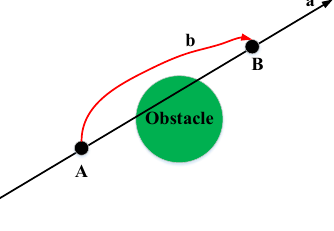
Fig. 6. Diagram of the modified